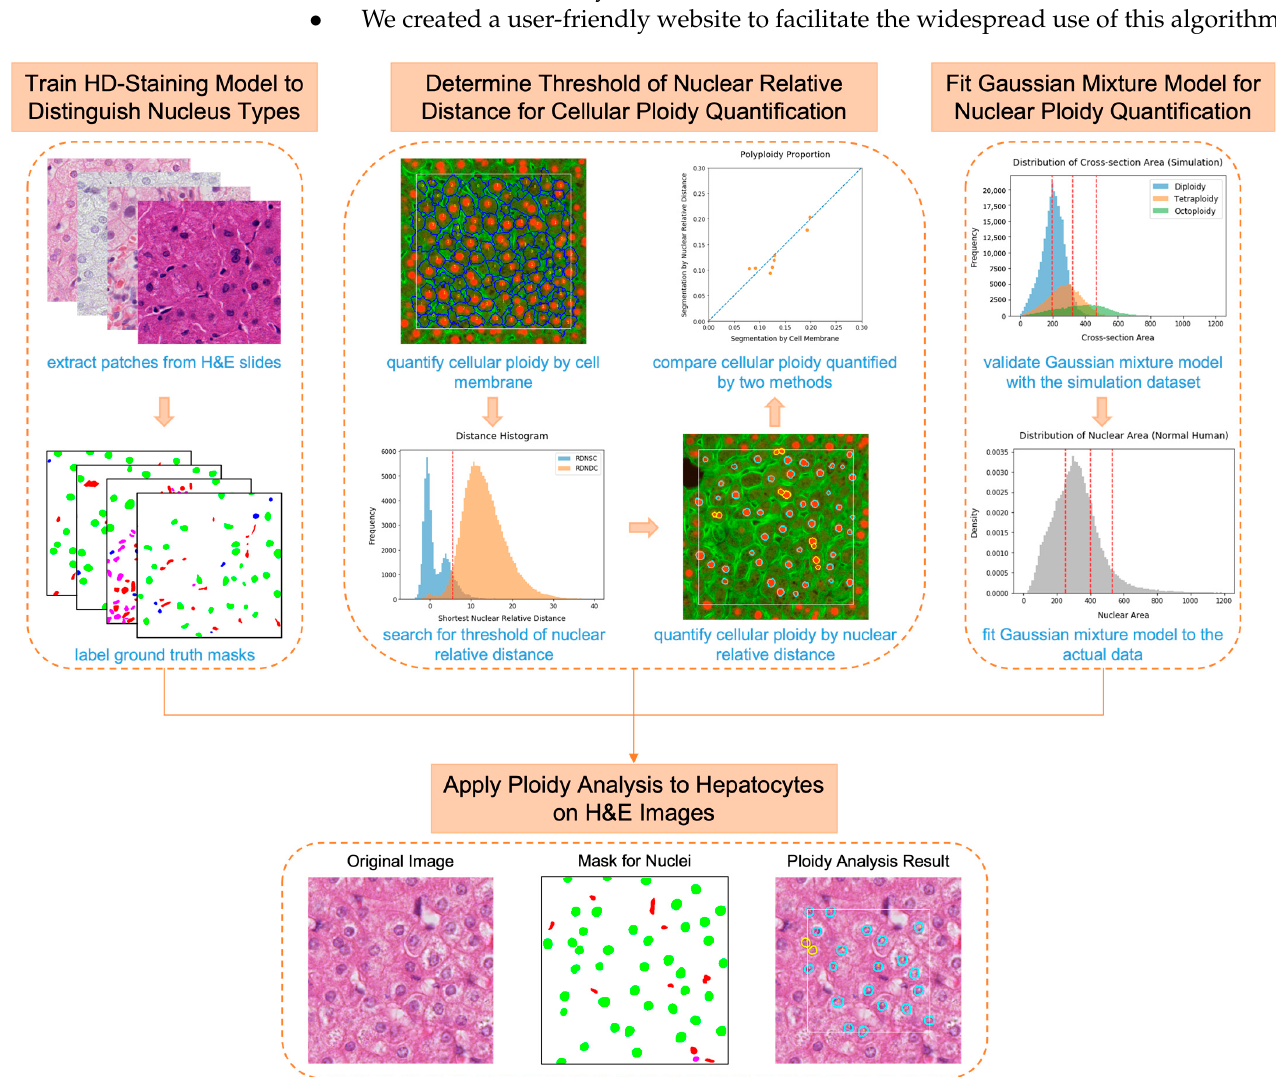
Figure 1. Development process of the automated hepatic ploidy quanti fi cation algorithm.